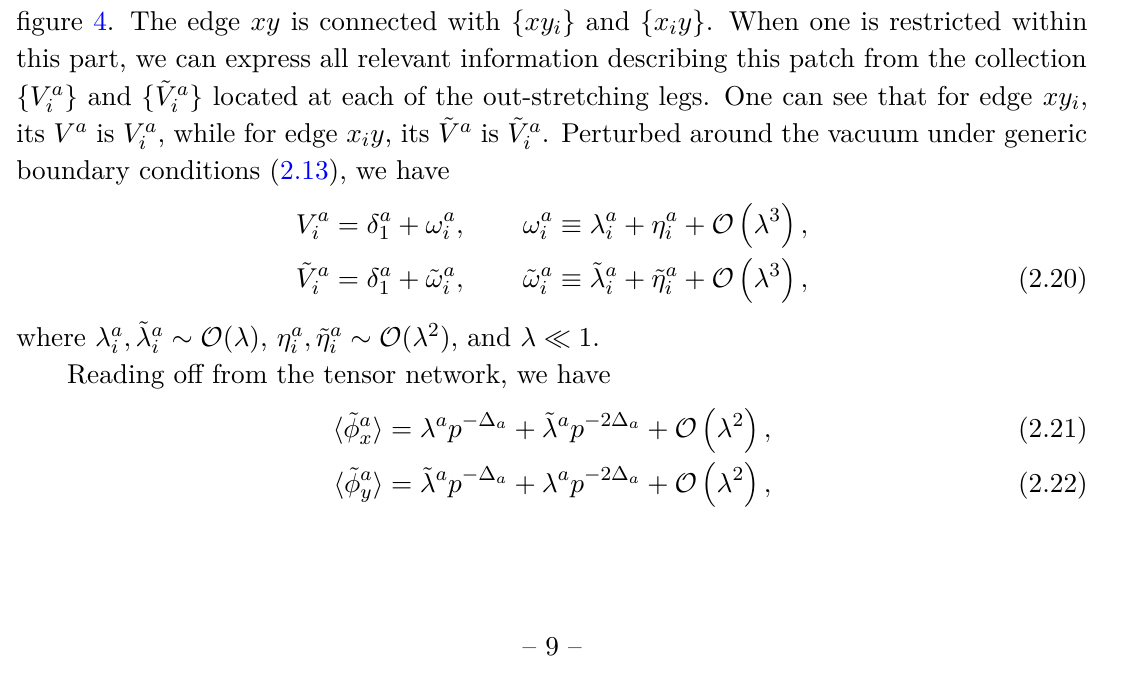
Figure 3 . (a): here we demonstrate the p = 2 case for simplicity. (b): the two black legs are bulk legs. We insert them near the vertices to make the labelling more transparent. They should be understood as inserted on the